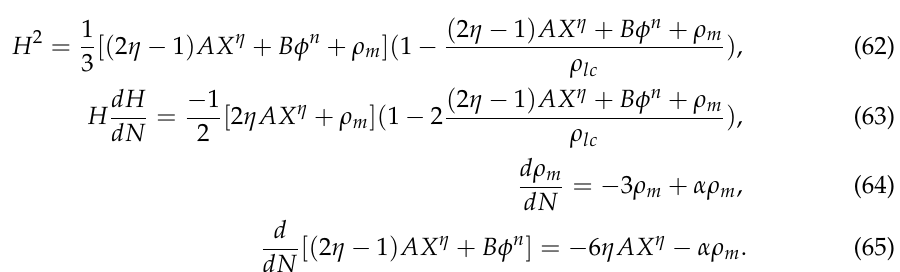
and 5 ,0,0,4 ) , while for α = − 0.01, 2 ,0,0,120 ) 60